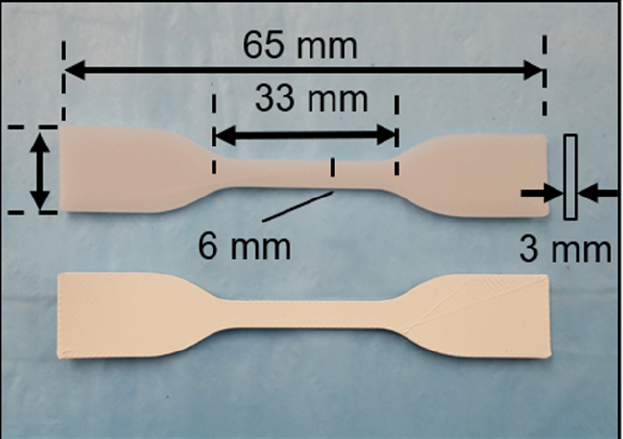
Figure 4. Digital image of the 3D-printed PCL and PCL-45BT scaffolds.